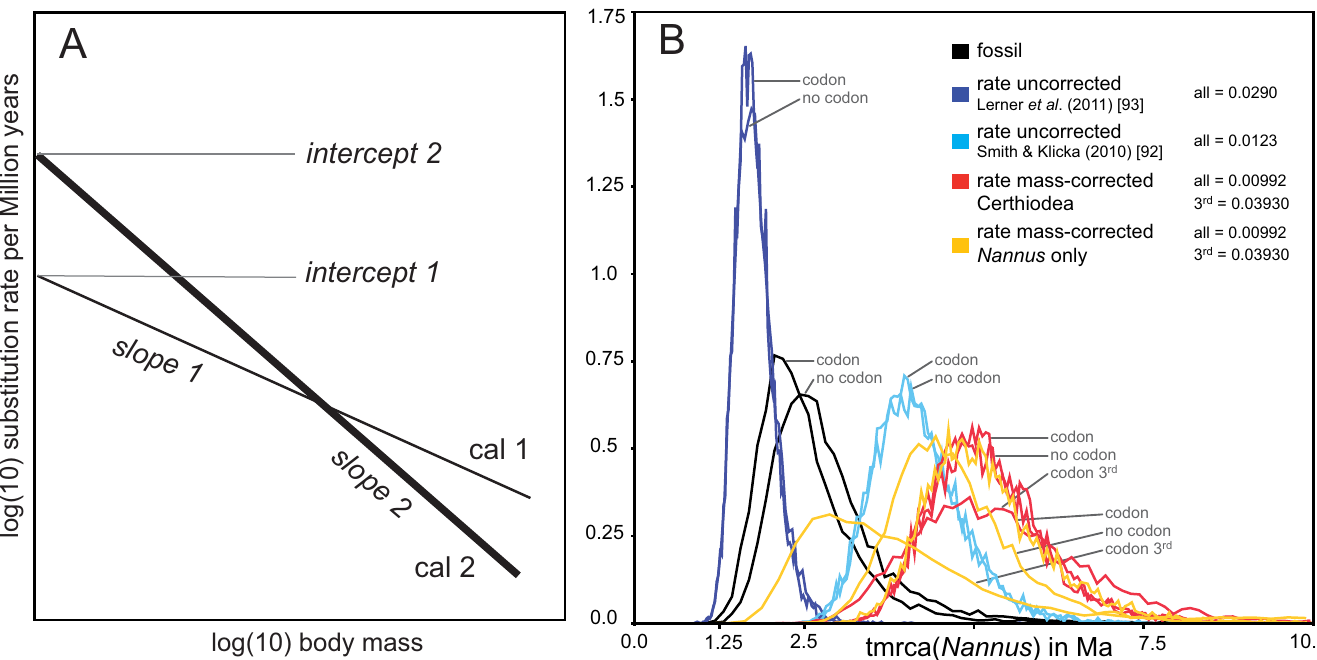
Fig 2. Inference of divergence time estimates from mitochondrial substitution rates. A: linear correlation between body mass and mitochondrial substitution rates in birds according to two calibration sets (cal1, cal2) by Nabholz et al . [99]; mass-corrected rates can be inferred from two parameters of the regression lines: slope and intercept; B: divergence time estimates for the time of the most recent common ancestor (tmrca) of Nannus according to 12 independent runs with BEAST; marginal density plots inferred from log output files with Tracer v.1.7.1; divergence time estimates were inferred from i) fossil calibration (by gene: ND2 treated as a single partition; by codon: ND2 partitioned by codon position), ii) two uncorrected rates for ND2 (from [92] and [93], each partitioned by gene or by codon; see above), iii) a mass-corrected rate for the entire ND2 gene of Nannus (partitioned by gene or by codon; see above), and iv) a mass corrected rate for the 3 rd codon position of ND2 in Nannu s (partitioned by codon; see above); rates in substitutions per site per lineage per Ma indicated at upper left.